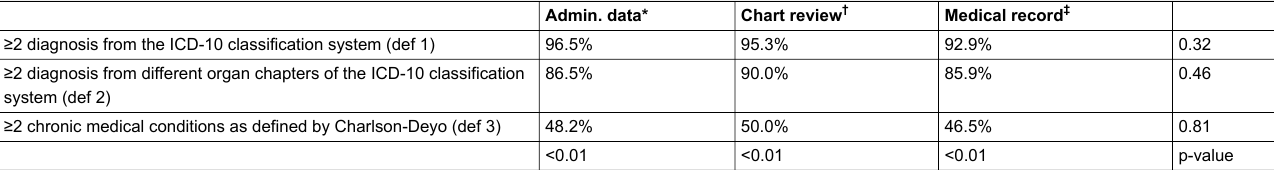
Admin. data* Chart review